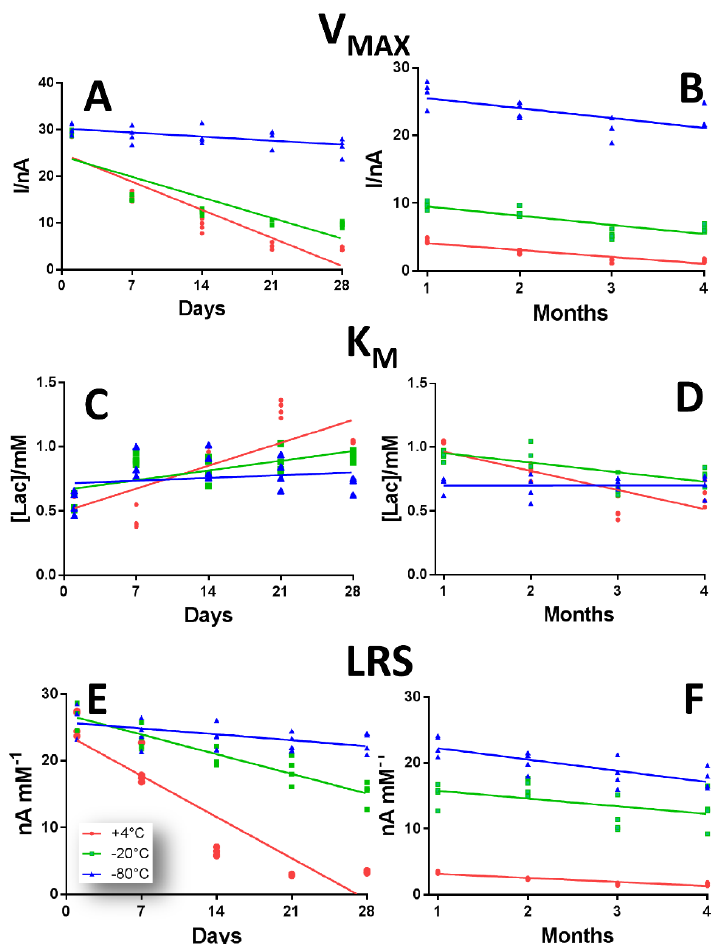
Figure 5. Scattering plot describing the variations of V MAX (Panel A and B), K M (Panel C and D) and LRS (Panel E and F), in a range of 28 days (left inset) and of four months (right inset) of LB2 design Ptc/PPD/[PEI (0.5%)-LOx] 5 / GTA(1%)-BSA (2%) in the defined range of 120 days, when stored at +4 °C (red plot), − 20 °C (green plot) and − 80 °C (blue plot). In panel A and B, V MAX variations are displayed. While +4 °C (red plot) and − 20 °C (green plot)